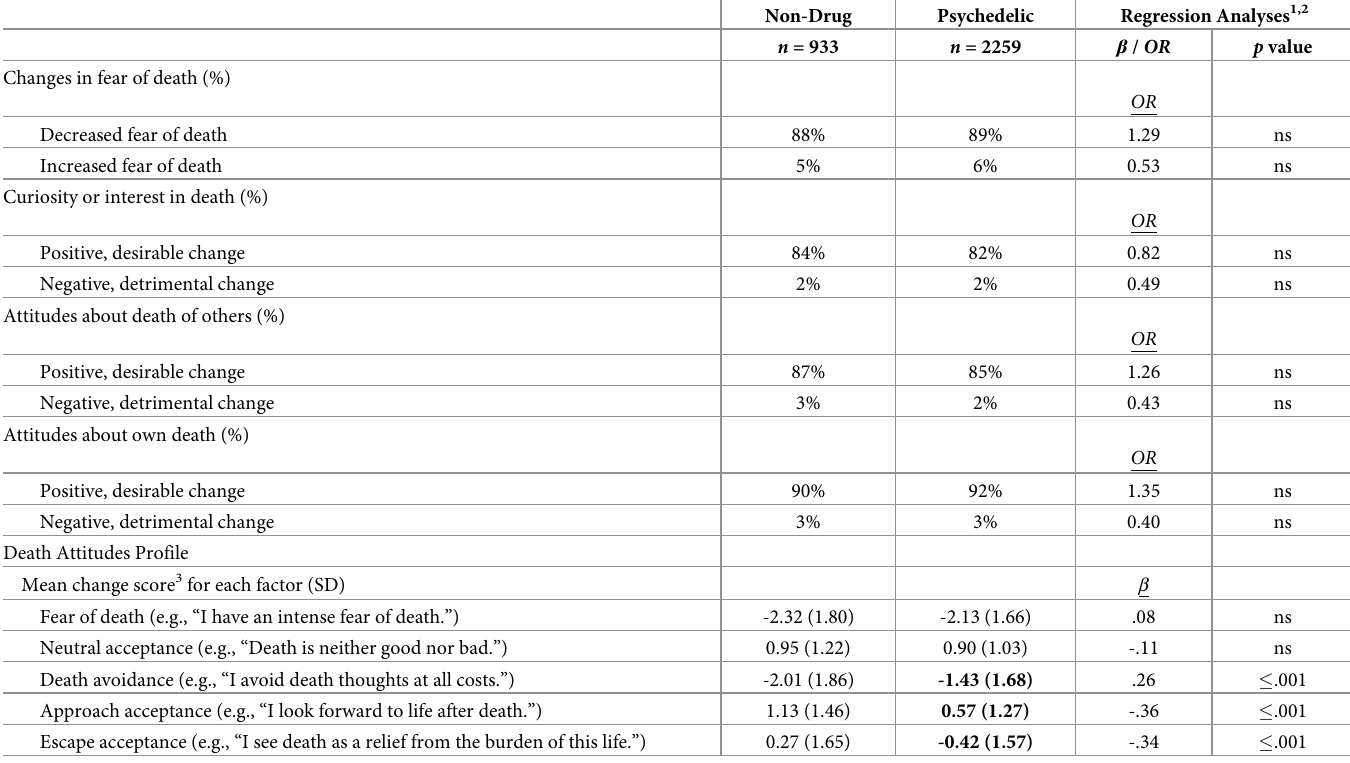
Table 7. Changes in death attitudes attributed to the experience among the Psychedelic Group and the Non-Drug Group.